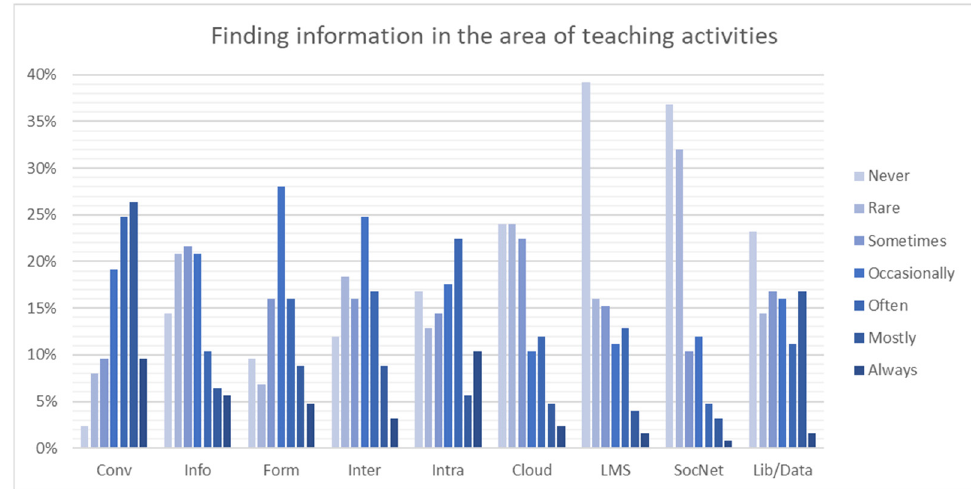
Figure 1. Ways of finding information in the area of teaching activities. (The complete legend is shown in Tables 1 and 2).